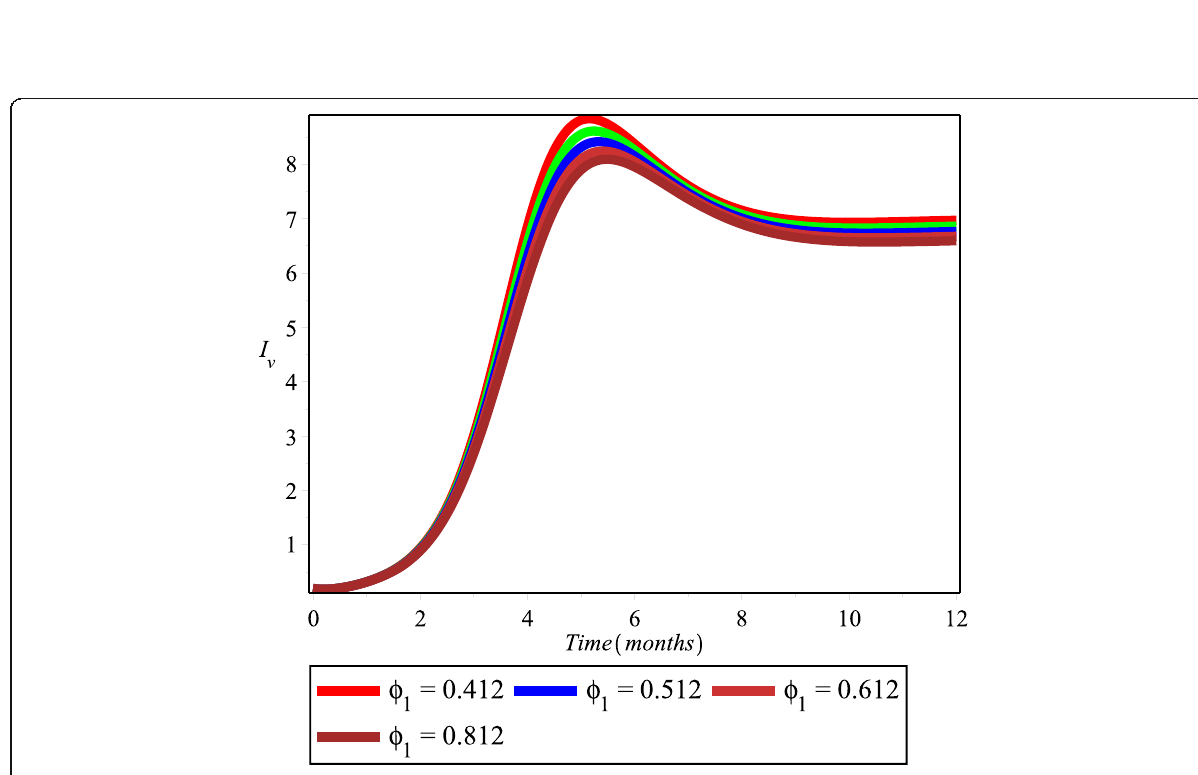
Fig. 3 Varying ϕ 1 (0.212 − 0.612) when R r < 1